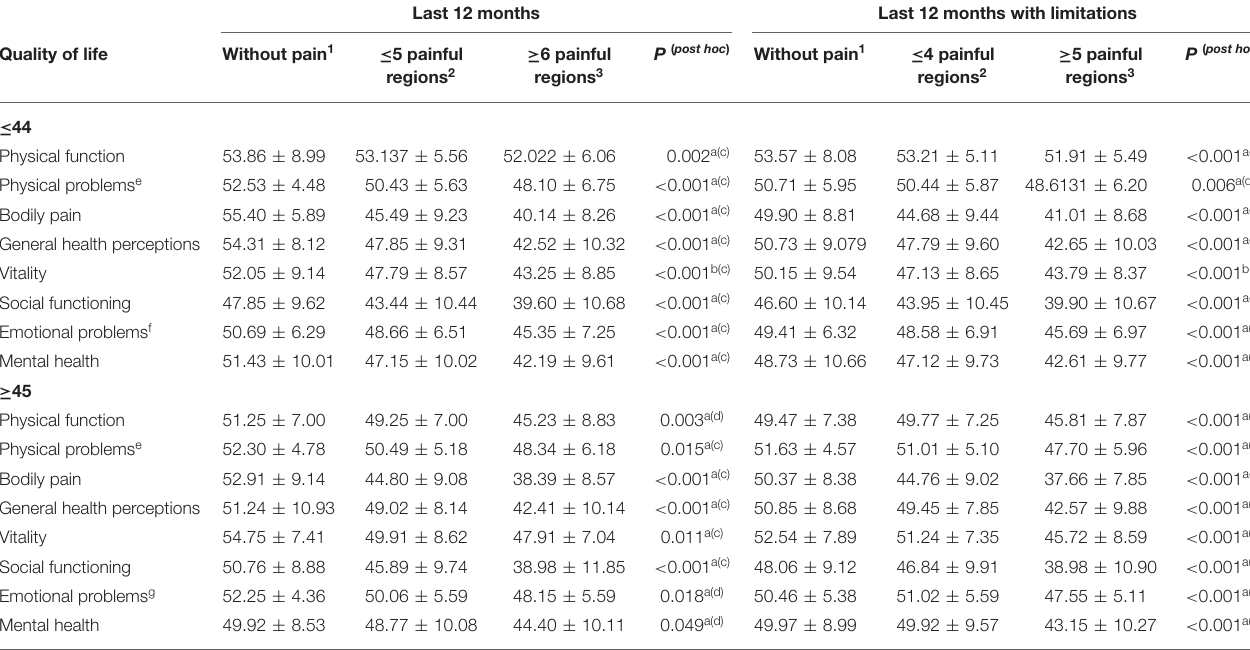
TABLE 5 | Evaluation of the differences in the scores of the eight quality of life scales between three categories of MSD according to age ranges. Last 12 months